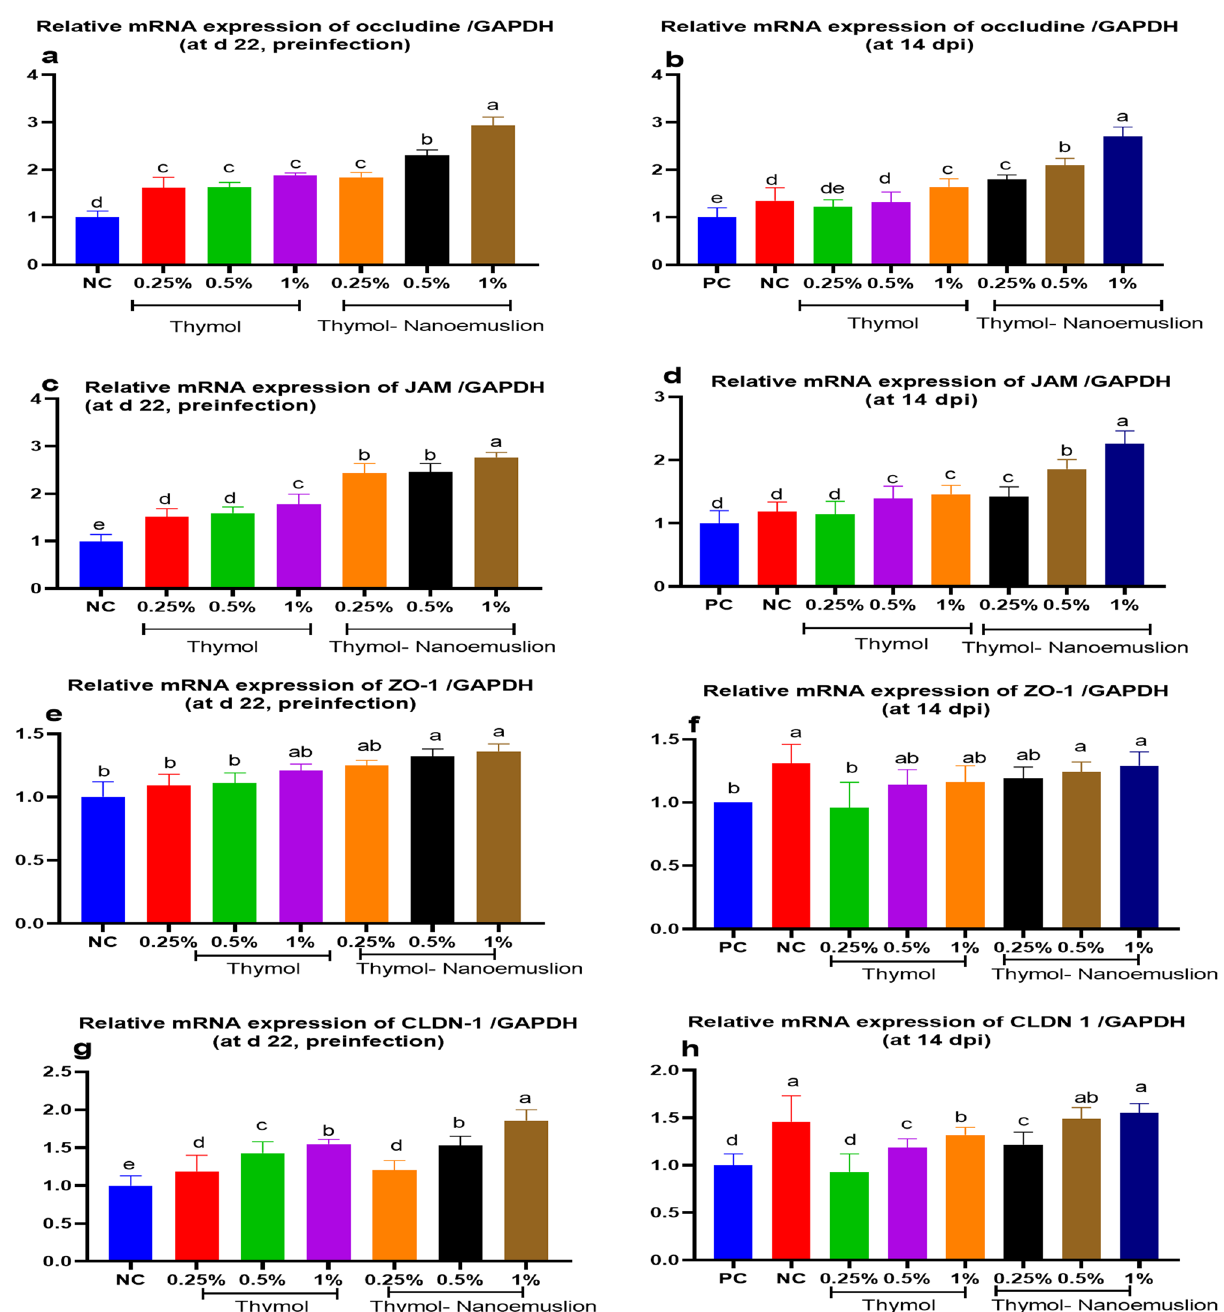
Figure 2. Real-time PCR analysis for occludin ( a , b ) junction adhesion molecule ( JAM ; c , d ) zonula occludens ( ZO- 1; e , f ) and claudins ( CLDN-1 ; g , h ) mRNAs expression in the cecal samples obtained from broilers fed a diet supplemented with different levels of thymol and thymol nanoemulsion preinfection (d 22) and 14 days postinfection (14 dpi) with S. Typhimurium. Data are presented as means ± SE. At d 22 preinfection: NC (negative control) = birds fed basal diet, thymol 0.25, 0.5 and 1% = birds fed basal diet supplemented with 0.25, 0.5 and 1% thymol, thymol nanoemulsion 0.25, 0.5 and 1% = birds fed basal diet supplemented with 0.25, 0.5 and 1% thymol nanoemulsion. At 14 dpi: NC (negative control): birds fed basal diet; PC (positive control): birds fed basal diet and challenged with S . Typhimurium at d 23 of age; thymol 0.25, 0.5 and 1%: birds fed basal diet supplemented with 0.25, 0.5 and 1% thymol; thymol nanoemulsion 0.25, 0.5 and 1%: birds fed basal diet supplemented with 0.25, 0.5 and 1% thymol nanoemulsion. All groups except NC group were challenged with S . Typhimurium at d 23 of age. a–e Means within the same column carrying different superscripts are significantly different at p <